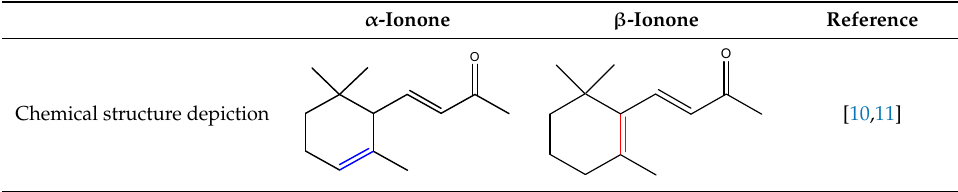
Table 1. The chemical structure of α -ionone and β -ionone.